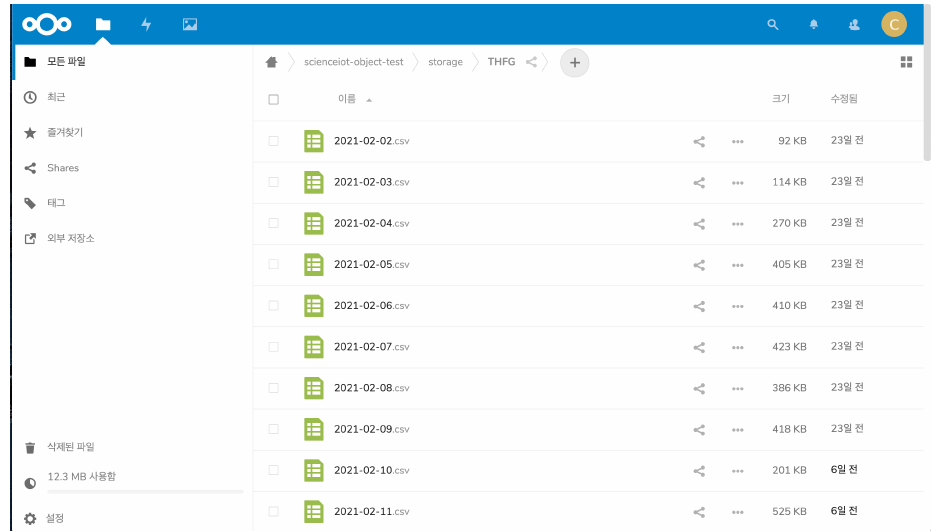
Figure 16. Data-sharing service based on the